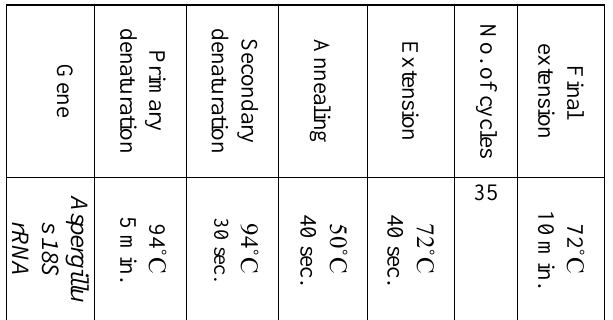
Table 2: Cycling conditions of the different primers during cPCR